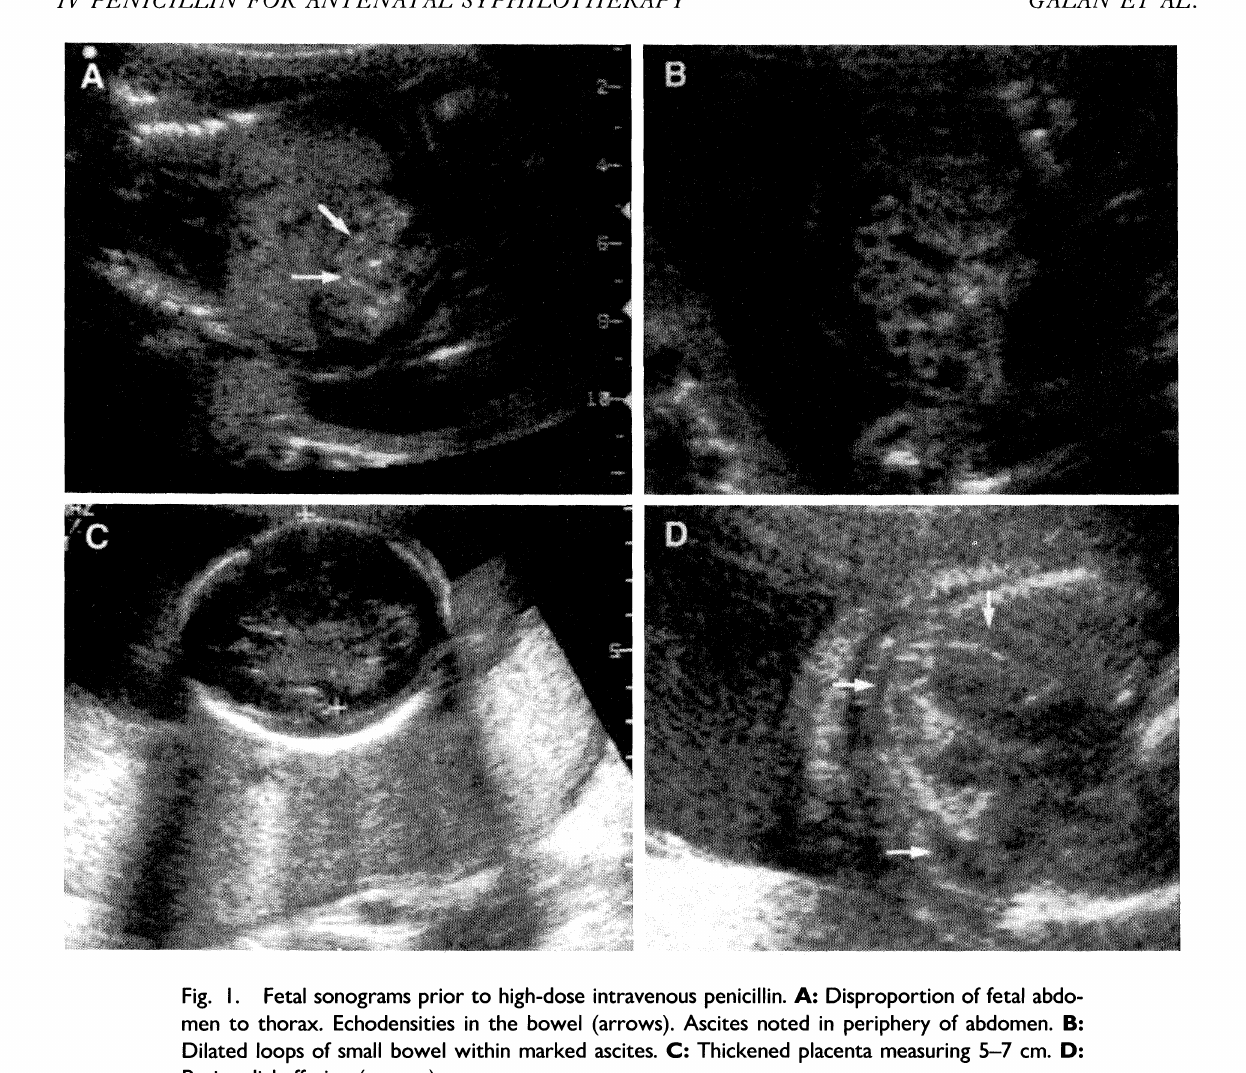
Fig. I. Fetal sonograms prior to high-dose intravenous penicillin. men to thorax. Echodensities in the bowel (arrows). Ascites noted in periphery of abdomen. ! Dilated loops of small bowel within marked ascites. C: Thickened placenta measuring 5-7 cm. D: Pericardial effusion